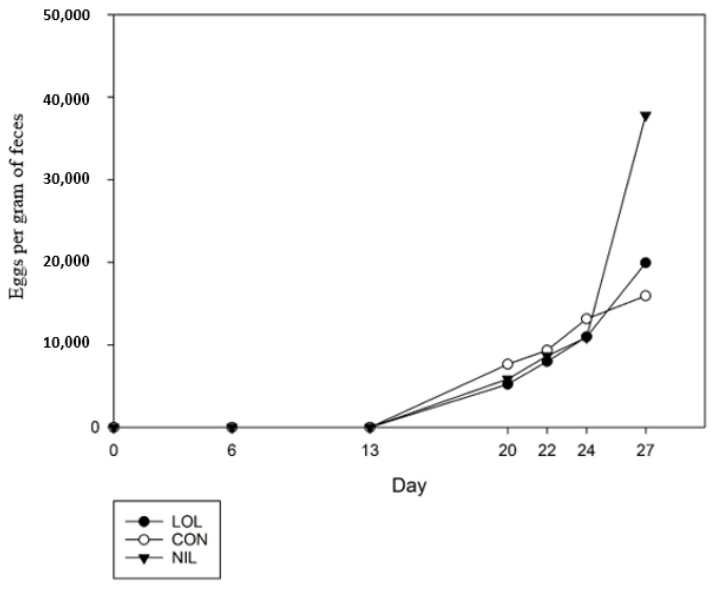
Figure 6. Average fecal egg counts of lambs with mixed parasite infection treated with a meadow fescue seed extract with (LOL) or without loline (NIL), or non-treated (CON). Average worm counts of CON or LOL-treated lambs at L4 stage of T. circumcincta , and T. colubriformis , or adult H. contortus are displayed in Table 5. Table 5. Average worm counts of lambs treated with a meadow fescue seed extract with (LOL, n = 7) or without loline (NIL, n = 2), or non-treated (CON, n = 7) at L4 or adult worm stage of Teladorsagia circumcincta , and Trichostrongylus colubriformis , or adult Haemonchus contortus